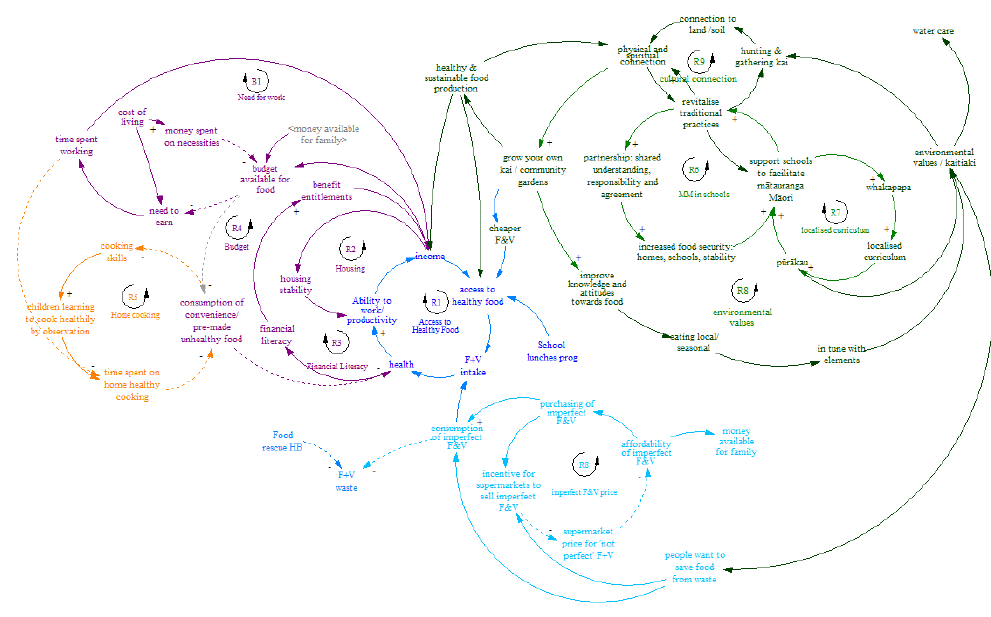
Figure 3. Adult–constructed food systems causal map.